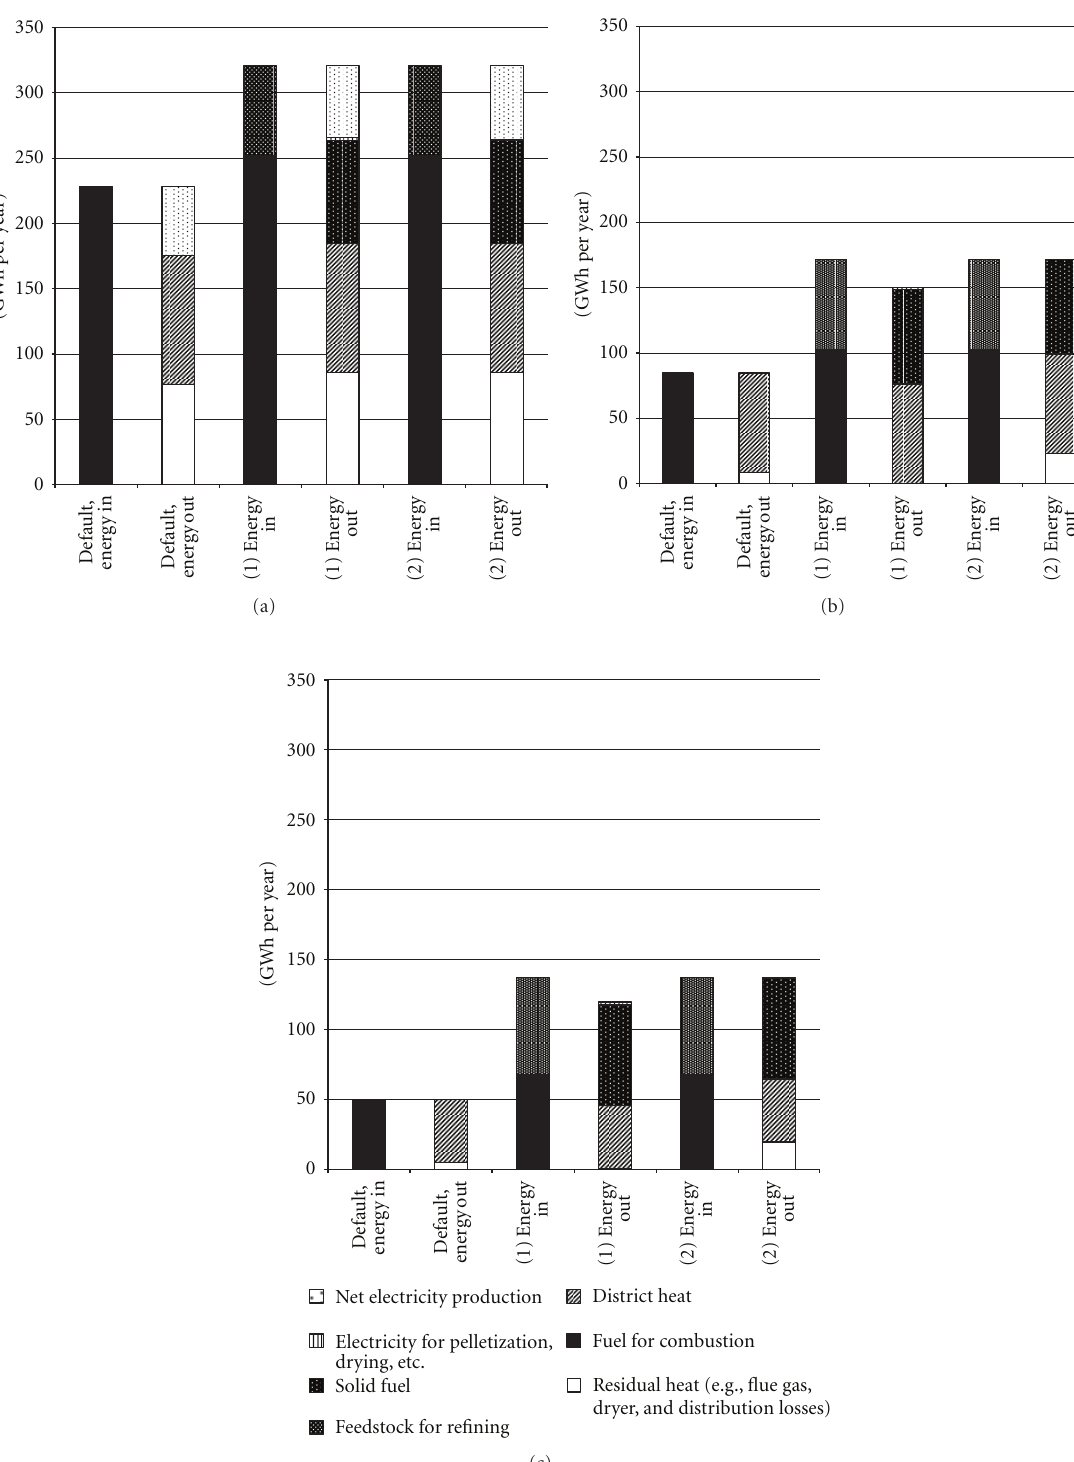
Figure 1: Energy balances for the three plant sites—Lycksele (a), Vilhemina (b), and V¨ann¨as (c)—under the current regime (default), for pellet production (1) and for pellet chip production